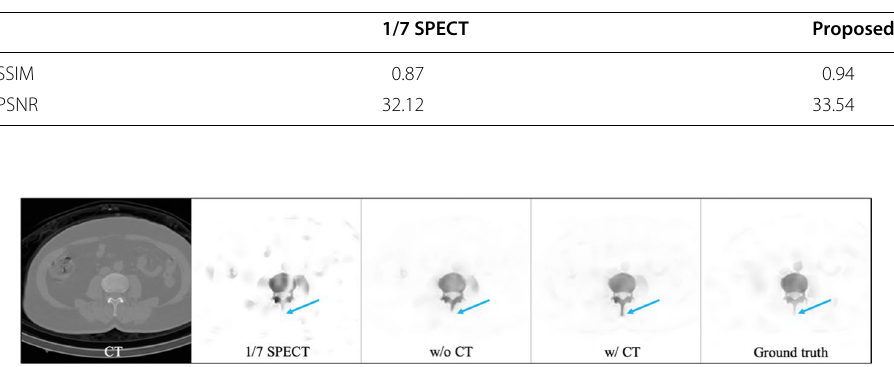
Table 3 Average SSIM and PSNR comparison for 1/7 SPECT and enhanced image